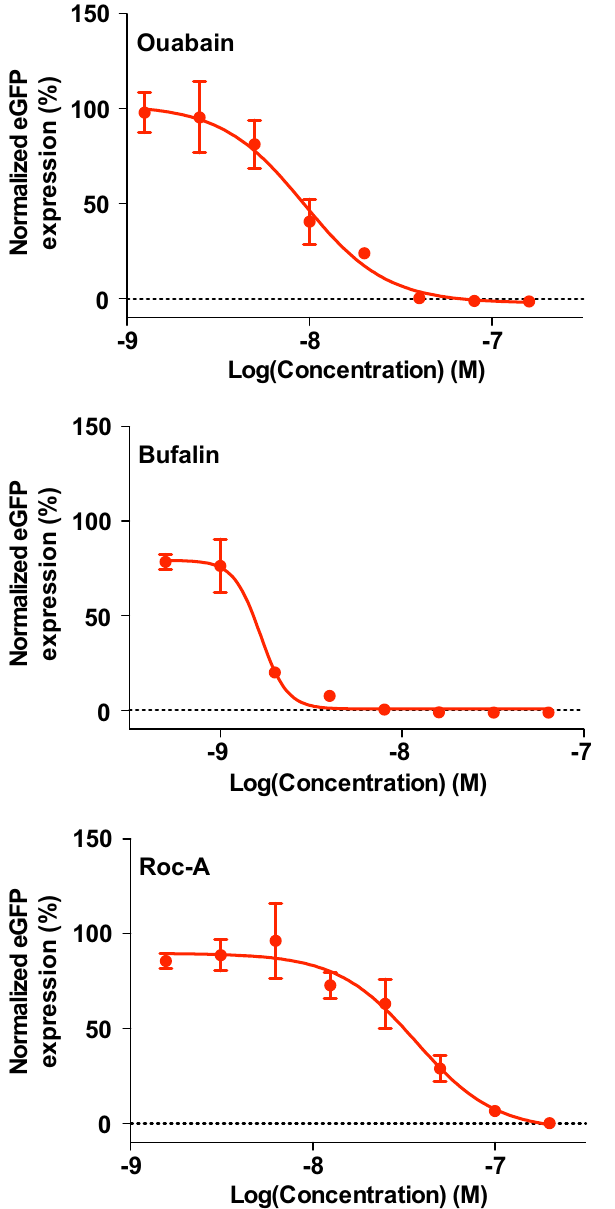
Fig 8. Inhibitory effects of ouabain, bufalin, and rocaglamide on LASV propagation. A549 cells seeded in a 96-well plate (3.0 x 10 4 cells/well) and cultured overnight were treated with 2-fold serial compound dilutions at 37˚C and 5% CO 2 for 2 h, followed by inoculation with rLASV/eGFP (MOI = 0.01). Compounds were present to study endpoint. At 48 h pi, cells were fixed with 4% PFA in PBS, and eGFP expression was examined by a fluorescent plate reader. Mean values obtained with DMSO-treated and rLASV/eGFP-infected cells were set to 100%. The data represent means ± SD of the results of three